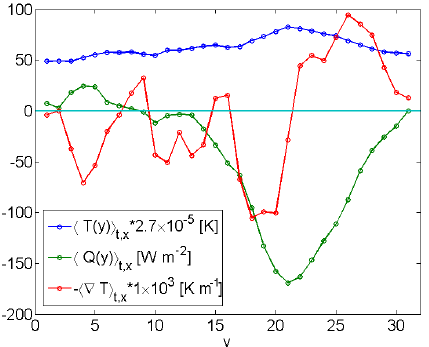
Figure 16. Heat flux profiles as a function of x for four values of the rank k